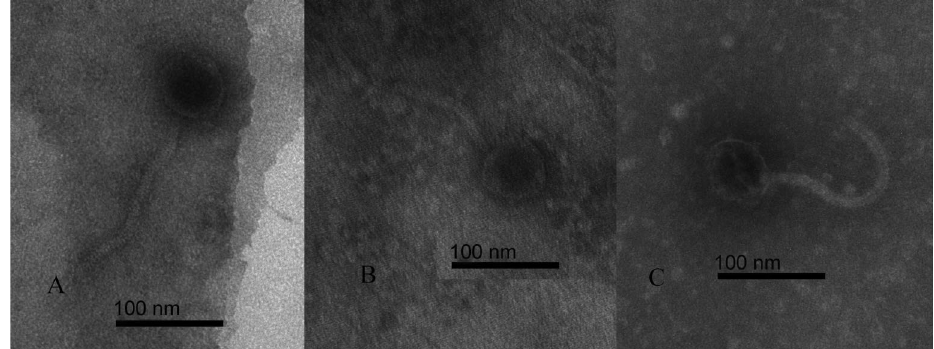
Figure 1. Family Siphoviridae bacteriophages isolated from clinical samples. The scale bar corresponds to 100 nm. A , Phage isolated from Pseudomonas aeruginosa P9583. B , Phage isolated from P. aeruginosa P9808. C , Phage isolated from P. aeruginosa P9842.